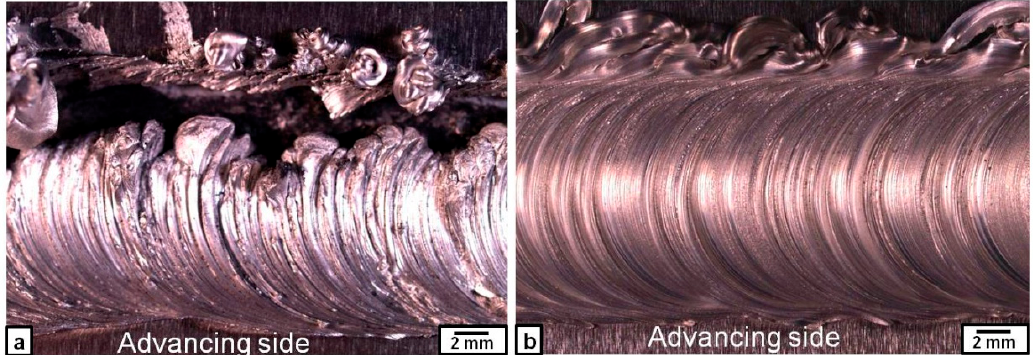
Figure 6. Macrographs of the top view of the nugget zone involving Fe 3 O 4 particles fabricated at rotation speeds of ( a ) 1000 rpm and ( b ) 1500 rpm.